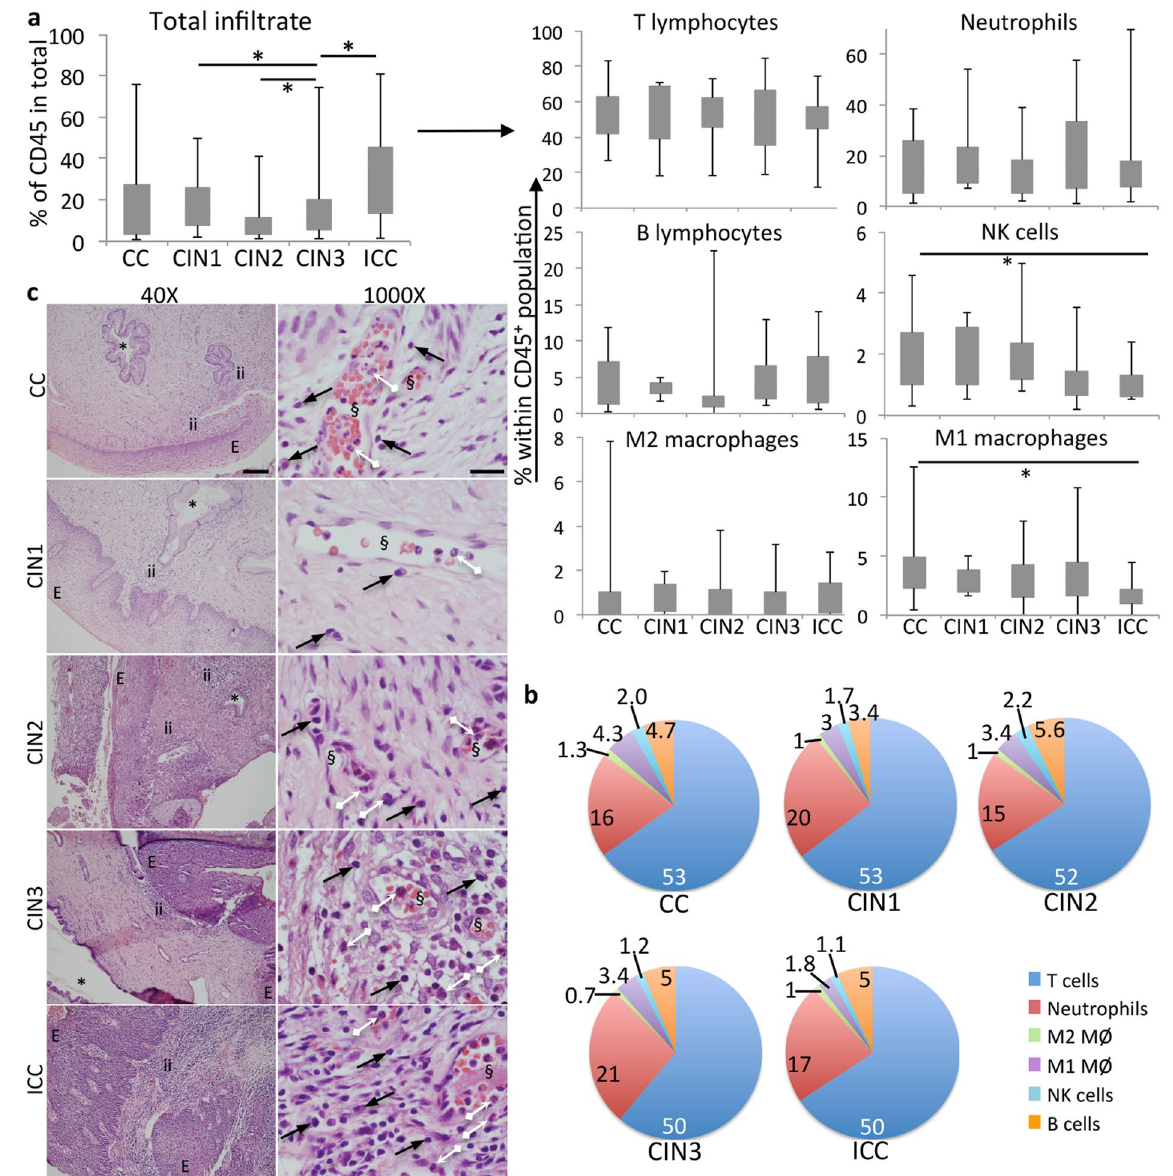
Figure 2. Leukocyte populations infiltrating cervical lesions. ( a ) Flow cytometry analyses of cervical single cell suspensions labeled with antibodies against cell surface markers. Total infiltrate corresponds to all CD45 + cells (box plot left side), all other box-plots are cells gated in the CD45 + population. Phenotype of each population is specified in Supplemental Material 1. Number of patients in each group is specified in Fig. 1. ( b ) Frequency of different cell populations per patient group. The values correspond the average frequency of each population; standard deviation values were omitted in the sake of space. Populations’ frequencies were compared by one-way ANOVA, * indicates significant differences in cells frequency among groups. ( c ) Histology of cervical tissues stained with HE. Image magnification is indicated, as well as lesion grade. E – epithelial compartment, ii – inflammatory infiltrate, * - glandular tissue, § - blood vessels, black arrows point to mononuclear cells, white arrows point to granulocytes. CC – cervicitis, CIN 1, 2, 3 – Cervical Intraepithelial Neoplasia grades 1, 2, 3, ICC – invasive cervical cancer. Scale bars indicate 250 μ m and 50 μ m in 40X and 1000X magnification micrographs (upper panels),